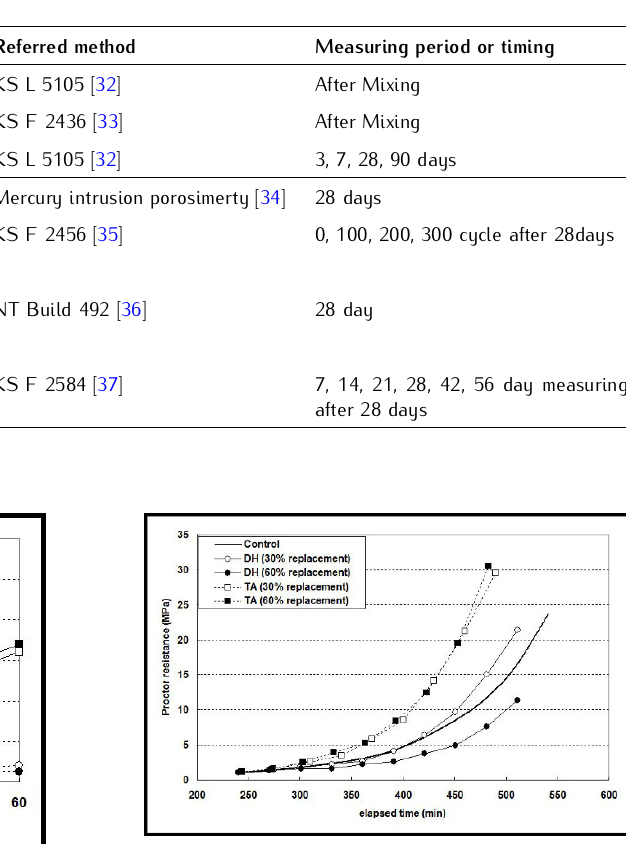
Table 6. Test items and related references [32–37].